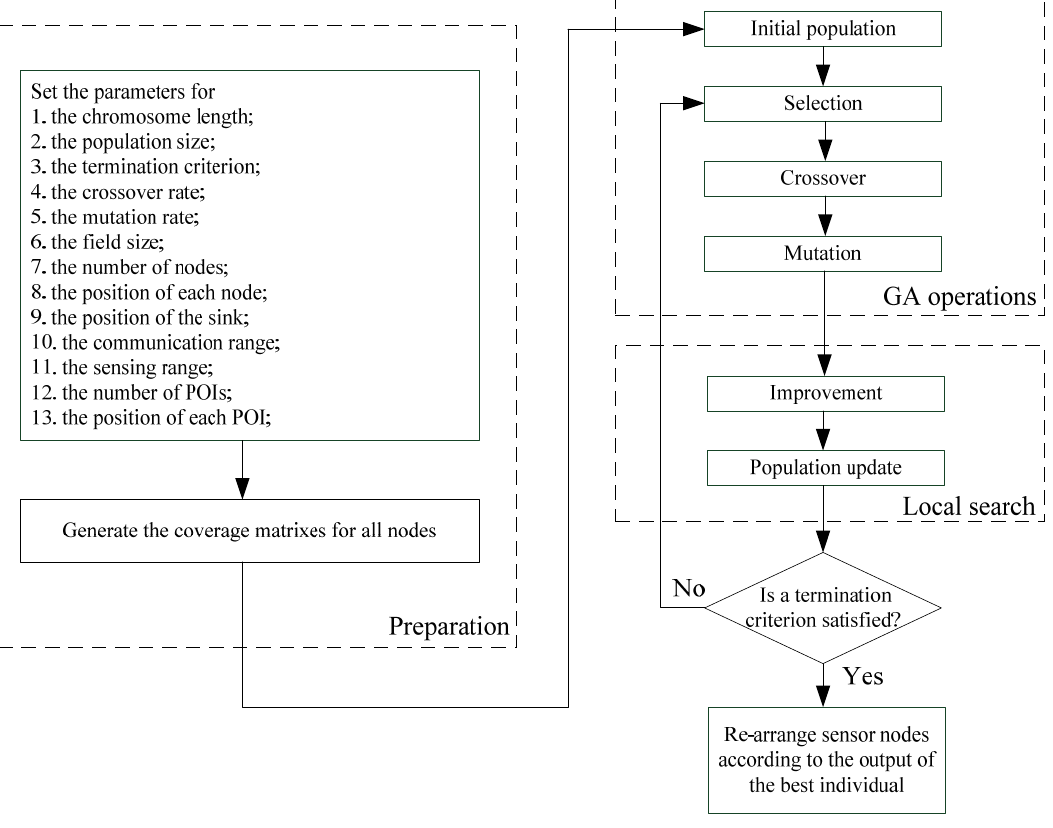
Figure 3. Flowchart of the optimization strategy using MA in the